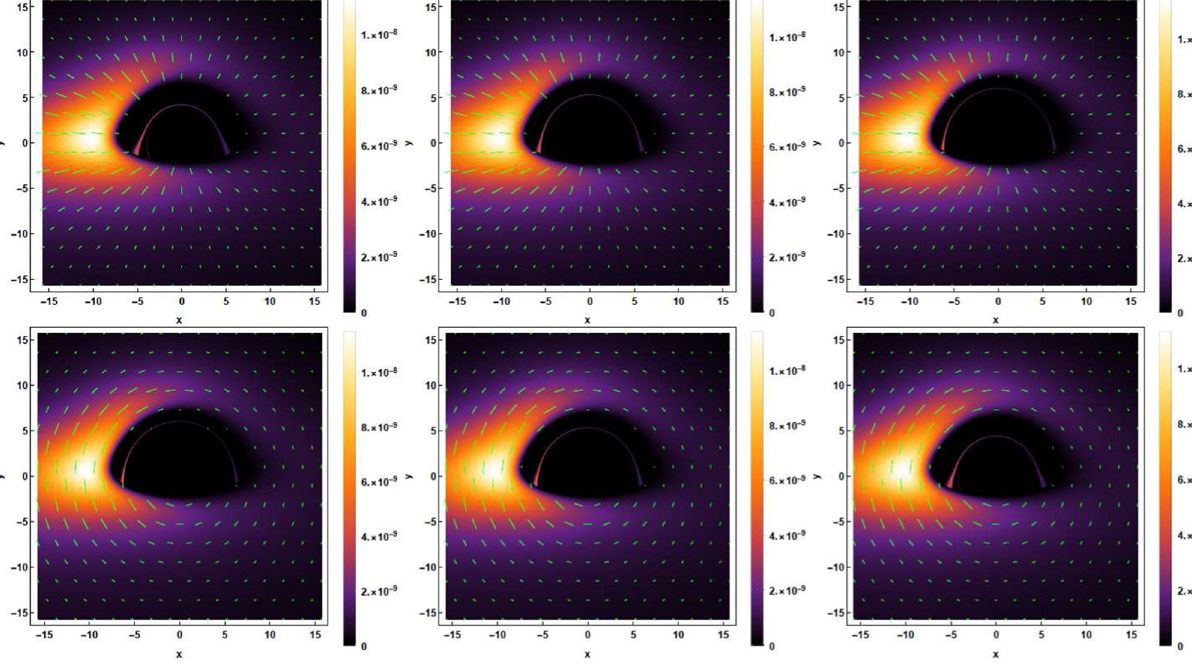
Fig. 7 Polarized intensity tick plots in the direct image for the fixed θ o = 70 ◦ . The upper row is for the PPL and the bottom row is for the PPM. In each row, the coupling parameter α in three panels from left to right is set to − 0 . 4, 0, and 0 . 4, respectively. Here, we set M =